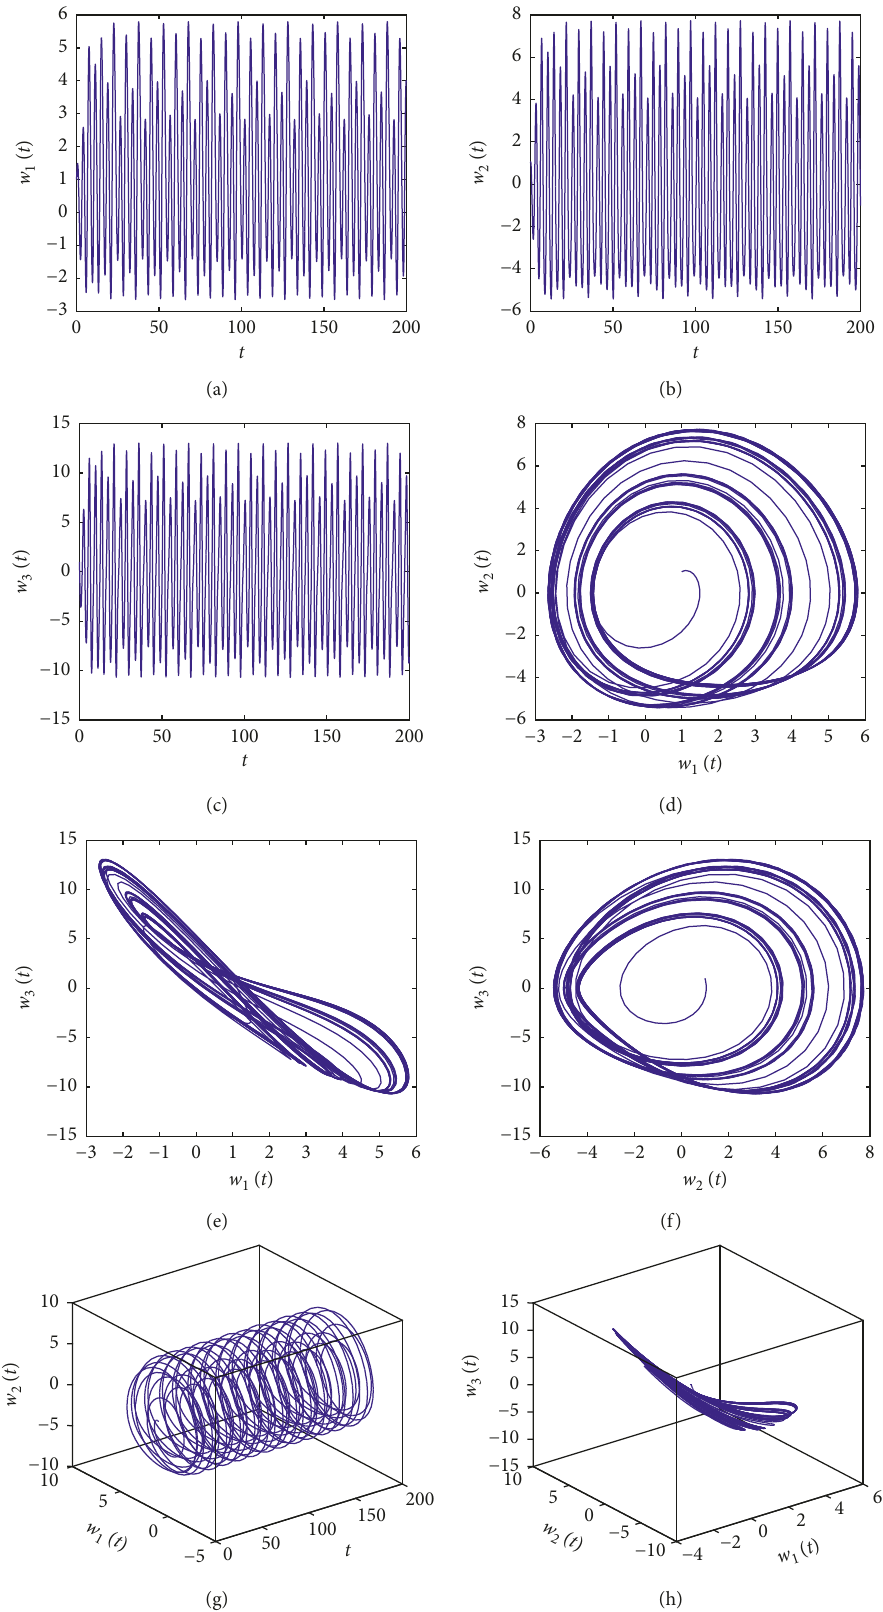
Figure 1: Dynamics of system (2) when σ � 0 . 87 and k